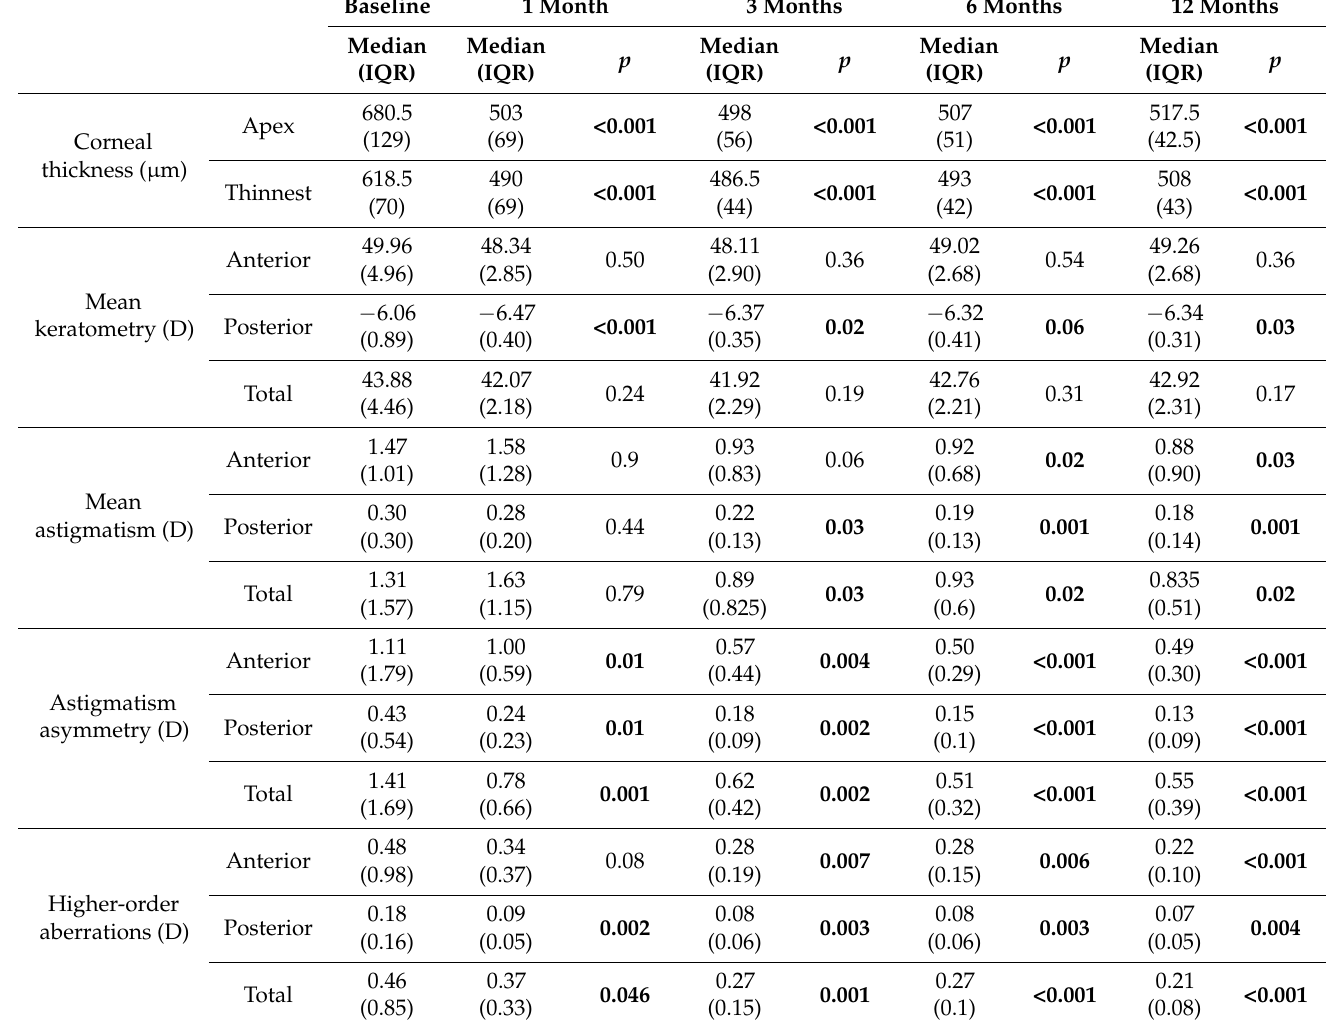
Table 2. Changes in the central corneal thickness (CCT), mean keratometry, astigmatism magnitude, astigmatism asymmetry and higher-order aberration power compared to the baseline in the 3 mm corneal optical zone after Descemet membrane endothelial keratoplasty (DMEK). Statistically significant values are shown in